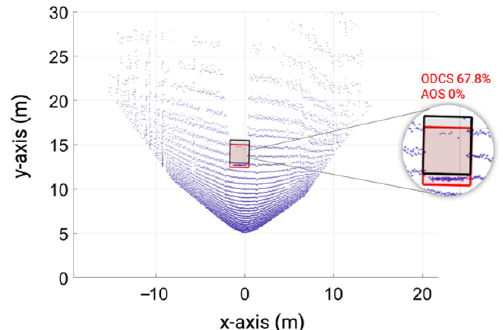
Figure 31. Exemplary visualization of inaccurate simulated point cloud data: The object detection score drops to 67.8% from 95.3%, and a − 0.8m offset in position leads to a shift in the 3D bounding box of the object predicted by the object detection algorithm, shown with the red color cuboid. The black cuboid shows the ground-truth 3D orientation of the